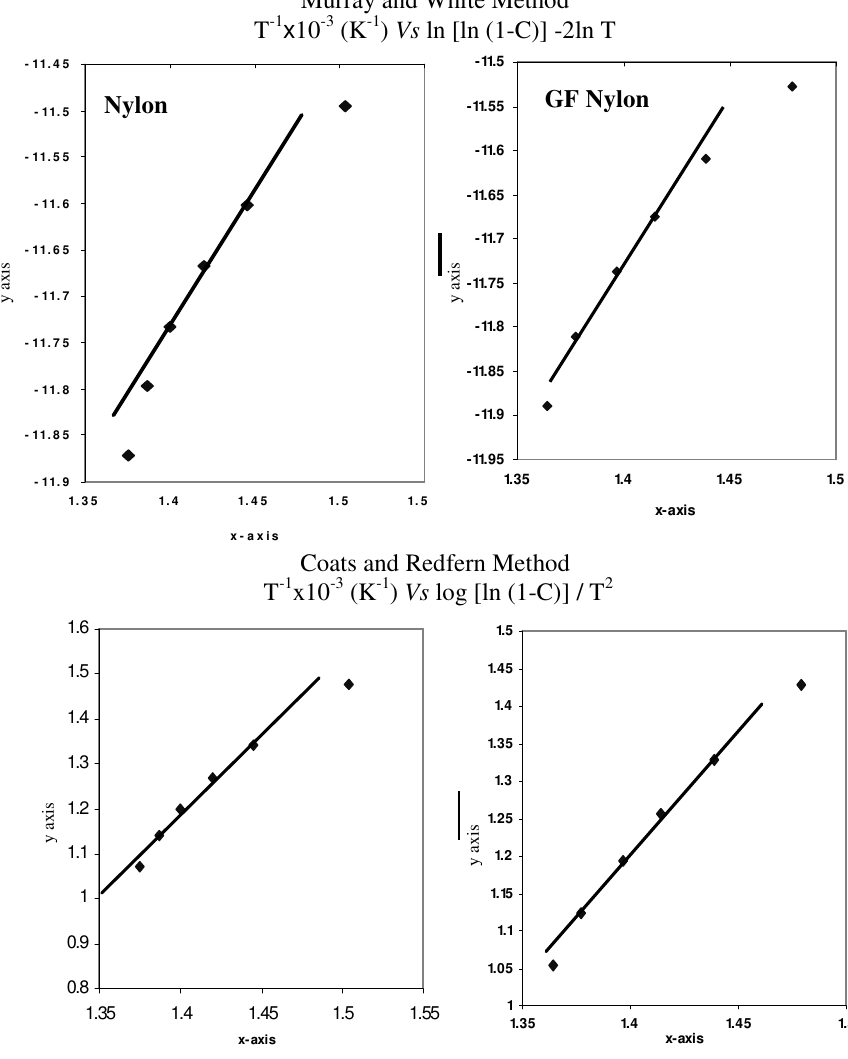
Figure 6. Arrhenius plot of degradation of polymer materials